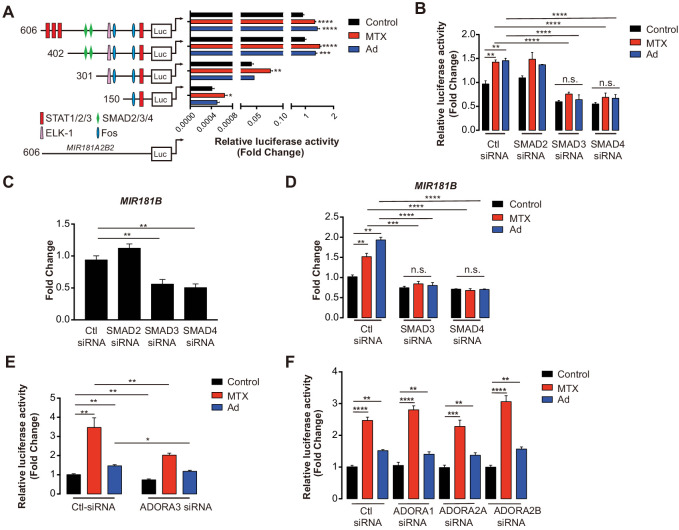
MIR181A2B2 promoter analysis in response to methotrexate (MTX) or Ad in endothelial cells (ECs).(A) Luciferase reporter constructs containing the indicated (0.606–5.1 kb 5’upstream) MIR181A2B2 promoter sequences were transfected in HEK 293 T cells and luciferase activity was measured 12 hr after treatment with MTX (10 µM) or Ad (50 µM), respectively. eight biological replicates. One-way ANOVA. (B) Luciferase reporter constructs containing the indicated (0.606 kb 5’upstream) MIR181A2B2 promoter sequences were transfected in HEK 293 T cells and luciferase activity was measured 12 hr after treatment with MTX (10 µM) or Ad (50 µM), respectively. Seven to eight biological replicates. One-way ANOVA. (C) Effect of siRNA-mediated knockdown for SMAD2, SMAD3, or SMAD4 in response to MTX or Ad on the 0.606 kb luciferase reporter. Three biological replicates. Unpaired two-tailed Student t test. (D–E) Real-time qPCR analysis of MIR181B expression in HUVECs transfected with siRNAs to negative control, SMAD2, SMAD3, or SMAD4 in the (D) absence or (E) presence of MTX (10 µM) or Ad (50 µM) for 4 hr. three biological replicates. Unpaired two-tailed Student t test. (F–G) Luciferase reporters containing the 0.606 kb miR-181a2b2 promoter were transfected in combination with siRNA to negative control or ADORA3 (F) or ADORA1, ADORA2A, or ADORA2B (G) and stimulated with MTX (10 µM) or Ad (50 µM). Please see Figure 3—source data 1. four biological replicates. Unpaired two-tailed Student t test. *p<0.05; **p<0.01; ***p<0.001; ****p<0.0001. All values represent mean ± SEM.Figure 3—source data 1.